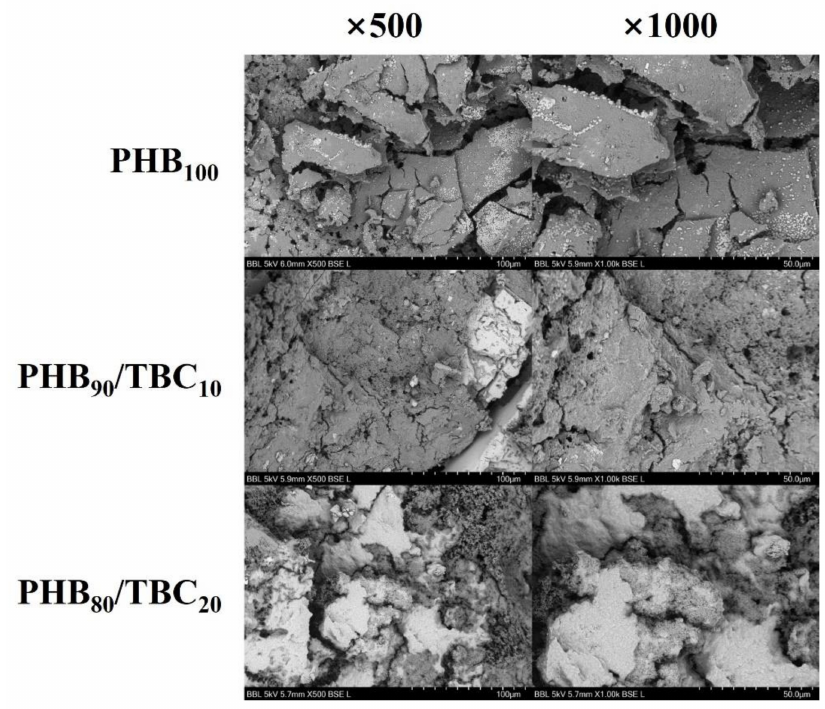
Figure 4. Representative images of surface changes observed by scanning electron microscopy. Comparison of differences in surface changes after two days of degradation by Microbulbifer sp. SOL66 through observation of 500 and 1000